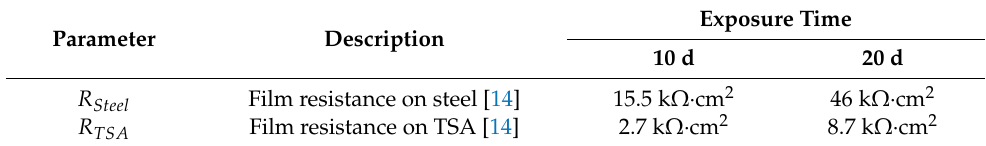
Table 2. Data from EIS